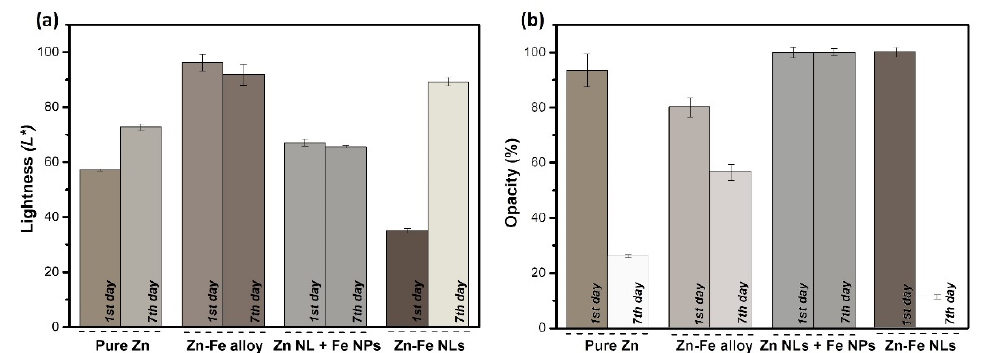
Figure 7. ( a ) Lightness ( L* ) values and ( b ) opacity percentages of the systems of pure Zn, Zn-Fe alloy, Zn NLs + Fe NPs, and Zn-Fe NLs being analyzed as deposited (1st day) and after being exposed at 98% relative humidity (7th day). Low L* values correspond to dark samples, while high L* values belong to light samples. The color of the bar represents the real color of the samples as simulated by RGB color model, not including the opacity in ( a ) and including the opacity values in ( b ).